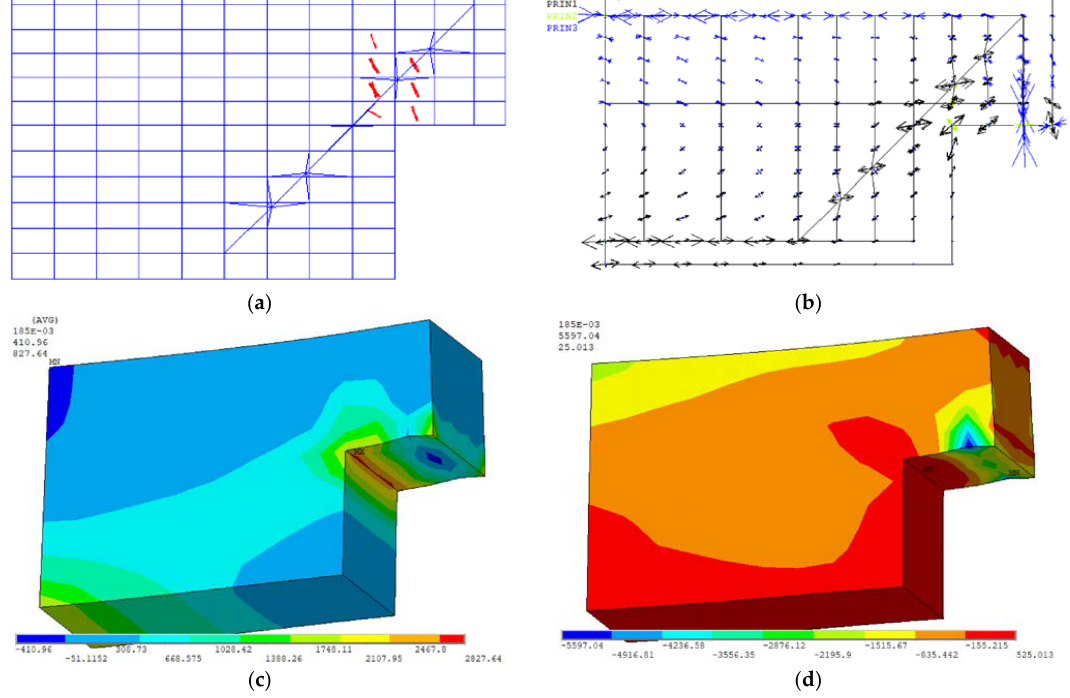
Figure 16. Half-joint in NS-REF configuration. ( a ) Cracking surfaces at collapse (87% final load); ( b ) vector plot of principal stresses just before collapse; ( c ) 1st principal stress just before collapse [kN/m 2 ]; ( d ) 3rd principal stress just before collapse [kN/m 2 ].